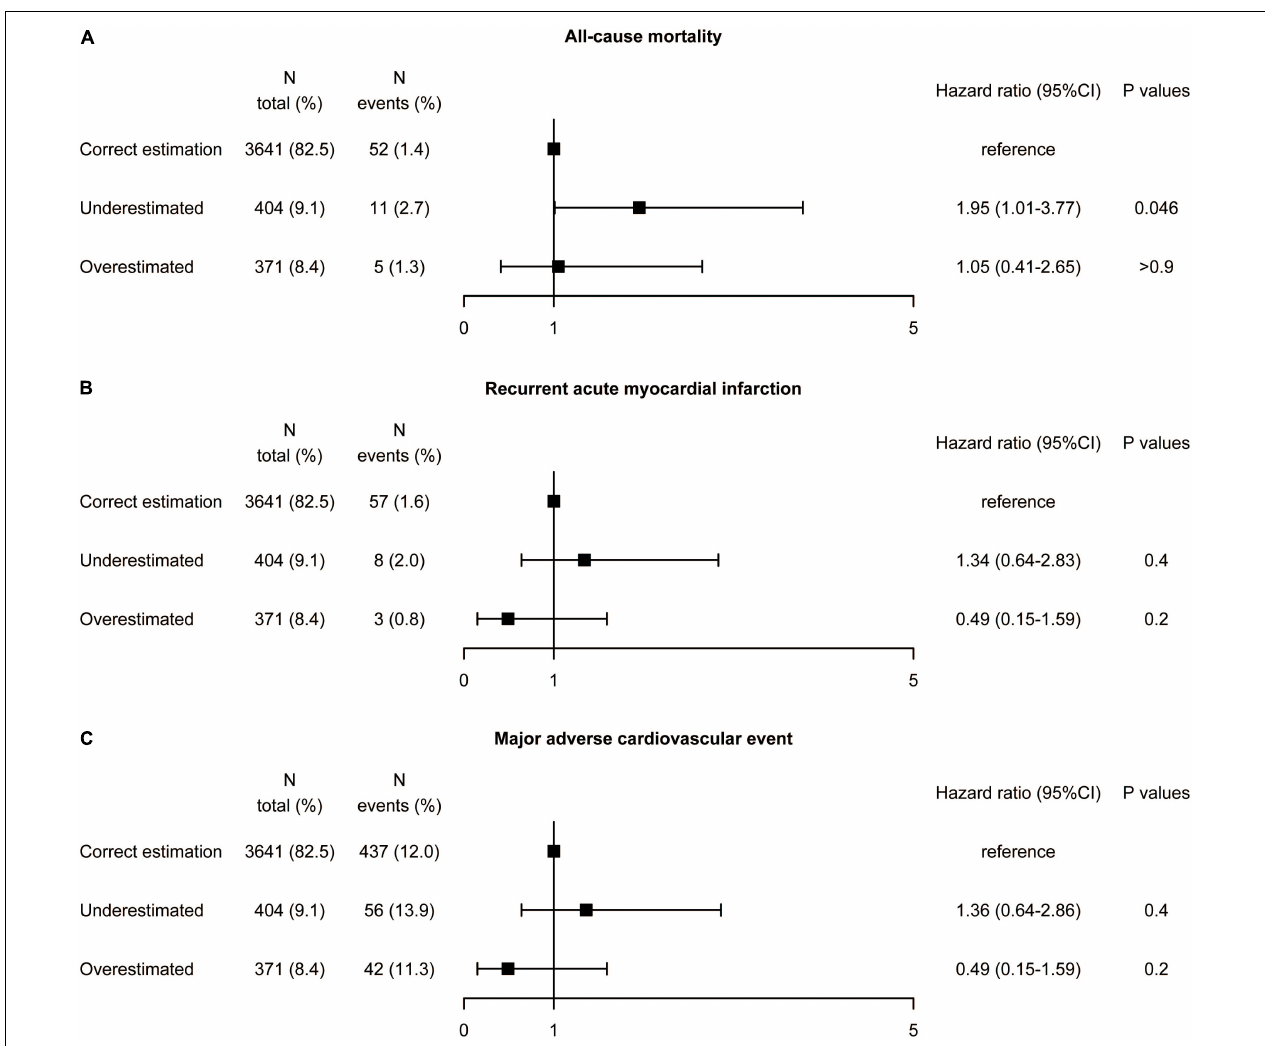
FIGURE 6 | Association between misclassification by the Martin equation and the risk of (A) all-cause mortality, (B) recurrent acute myocardial infarction, and (C) major adverse cardiovascular event by multivariate analysis in patients with diabetes. Hazard ratios were from Cox proportional hazards regressions with multivariable analysis. CI, confidence